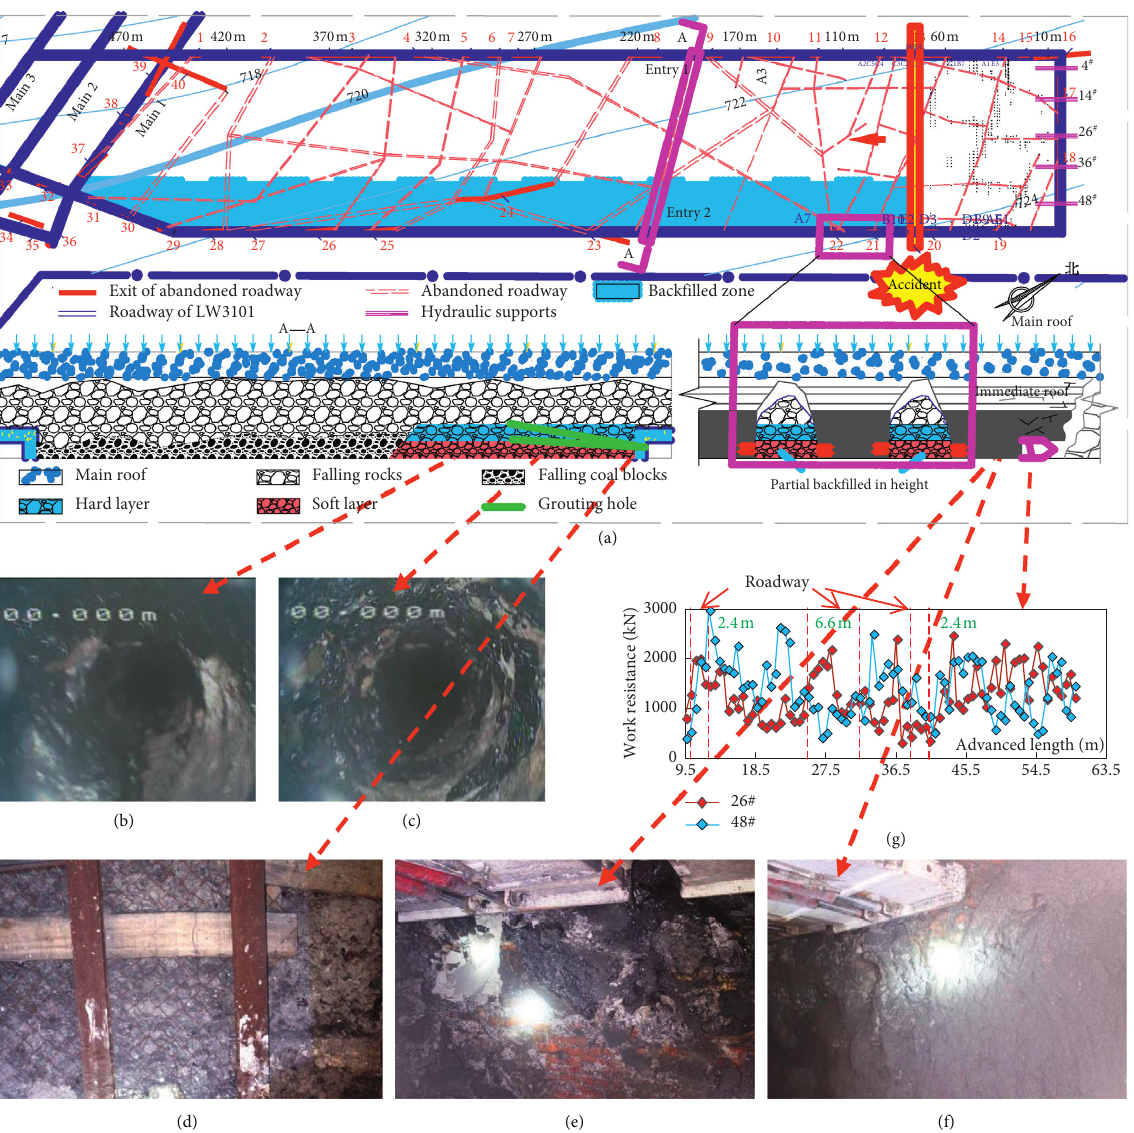
Figure 13: The method of backfilling abandoned roadway on Panel LW3101. (a) Backfilling method, (b) borehole peep photos i, (c) borehole peep photos (ii), (d) photo about the entrance of this abandoned roadway, (e) photo about mining face i , (f) photo about mining face (ii), and (g) work